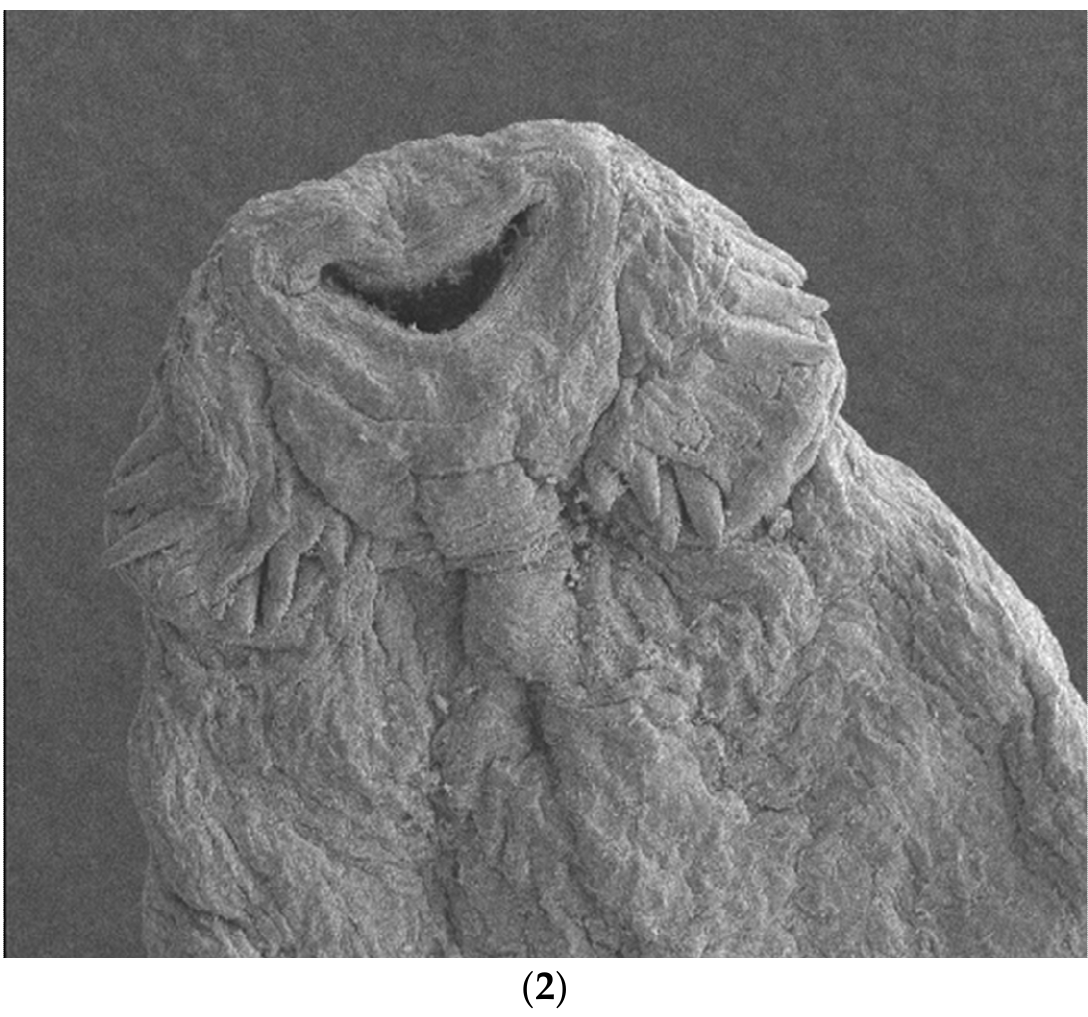
Figure 6. Electron micrographs of ( 1 ) the mouth opening and collar spines of Echinostoma revolutum , and ( 2 ) of the ovoid proboscis of Polymorphus minutus .